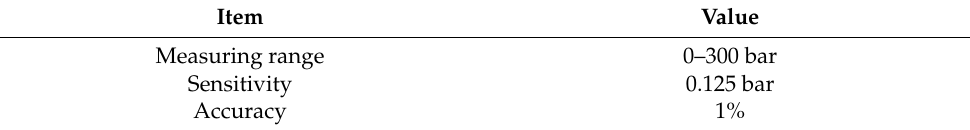
Table 3. Specifications of the master cylinder pressure